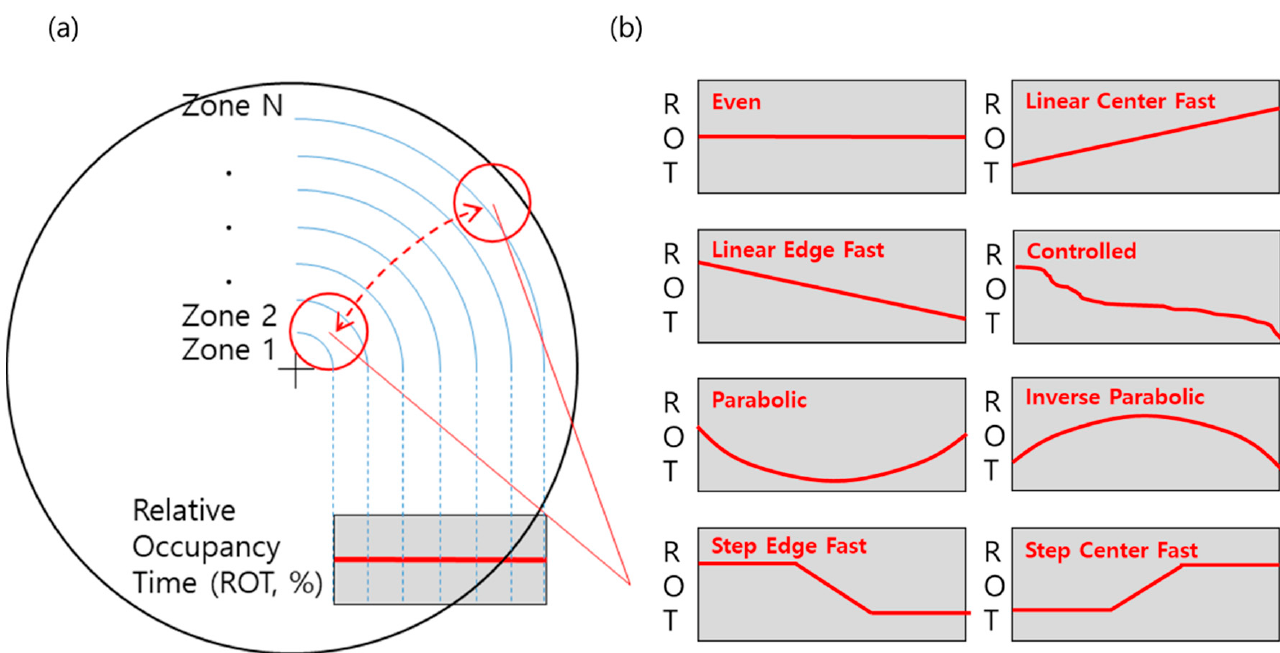
Figure 3. ( a ) Schematic of conditioning zone and Relative occupancy time (ROT), ( b ) Schematic of the eight conditions used in experiments and predictions. Table 2. Relative occupancy time (ROT, %) of profile cases; parabolic, inverse parabolic, step center fast, and step edge fast. Zone